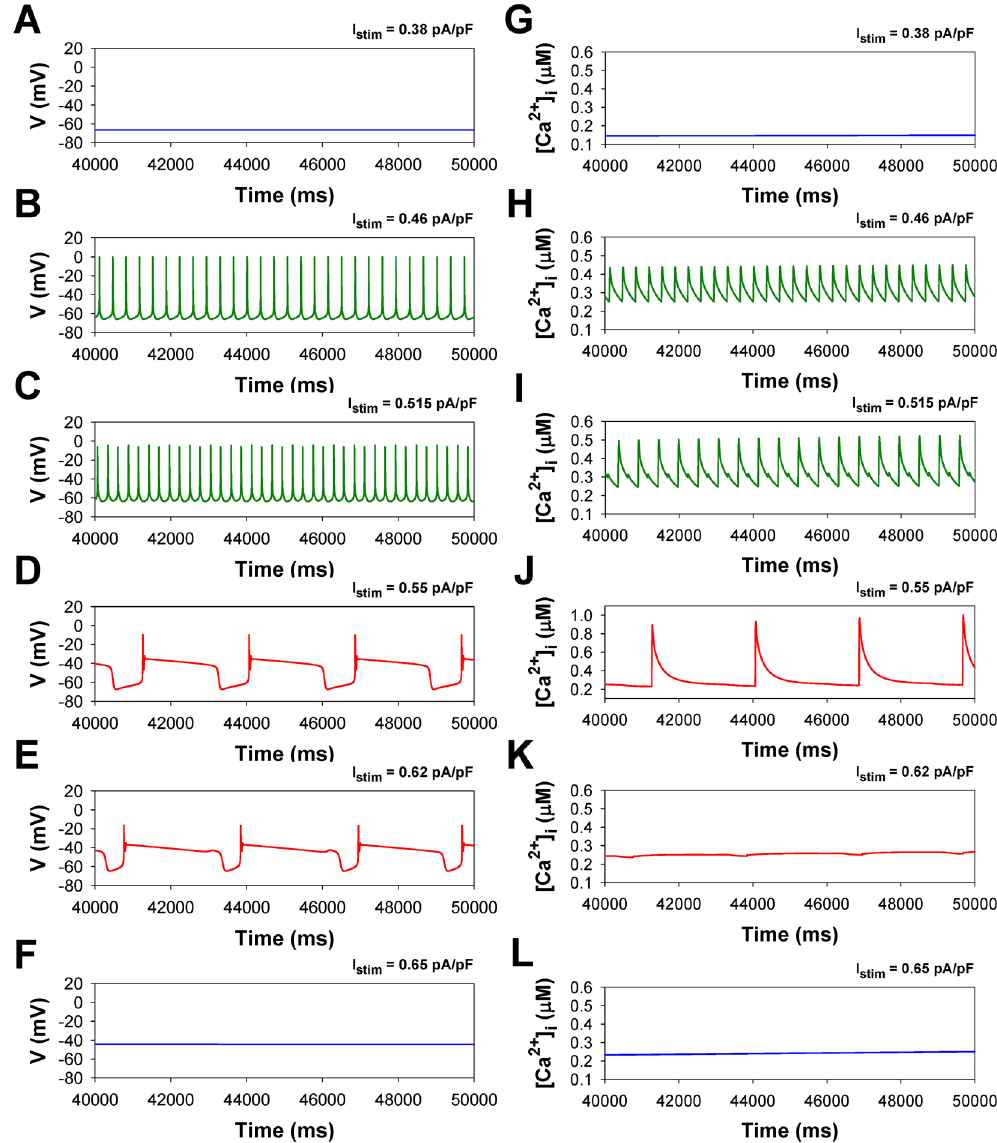
Figure 7. Simulated time series of AP (Panels A–F) and [Ca 2 + ] i transients (Panels G–L) in characteristic points of bifurcation diagrams for TNF- α overexpressing mouse ventricular myocytes in Fig. 6 during injection of continuous current: I stim = 0.38 pA/pF (Panels A,G); I stim = 0.46 pA/pF (Panels B,H); I stim = 0.515 pA/pF (Panels C,I); I stim = 0.55 pA/pF (Panels D, J); I stim = 0.62 pA/pF (Panels E,K); I stim = 0.65 pA/pF (Panels F,L). I Na with slow